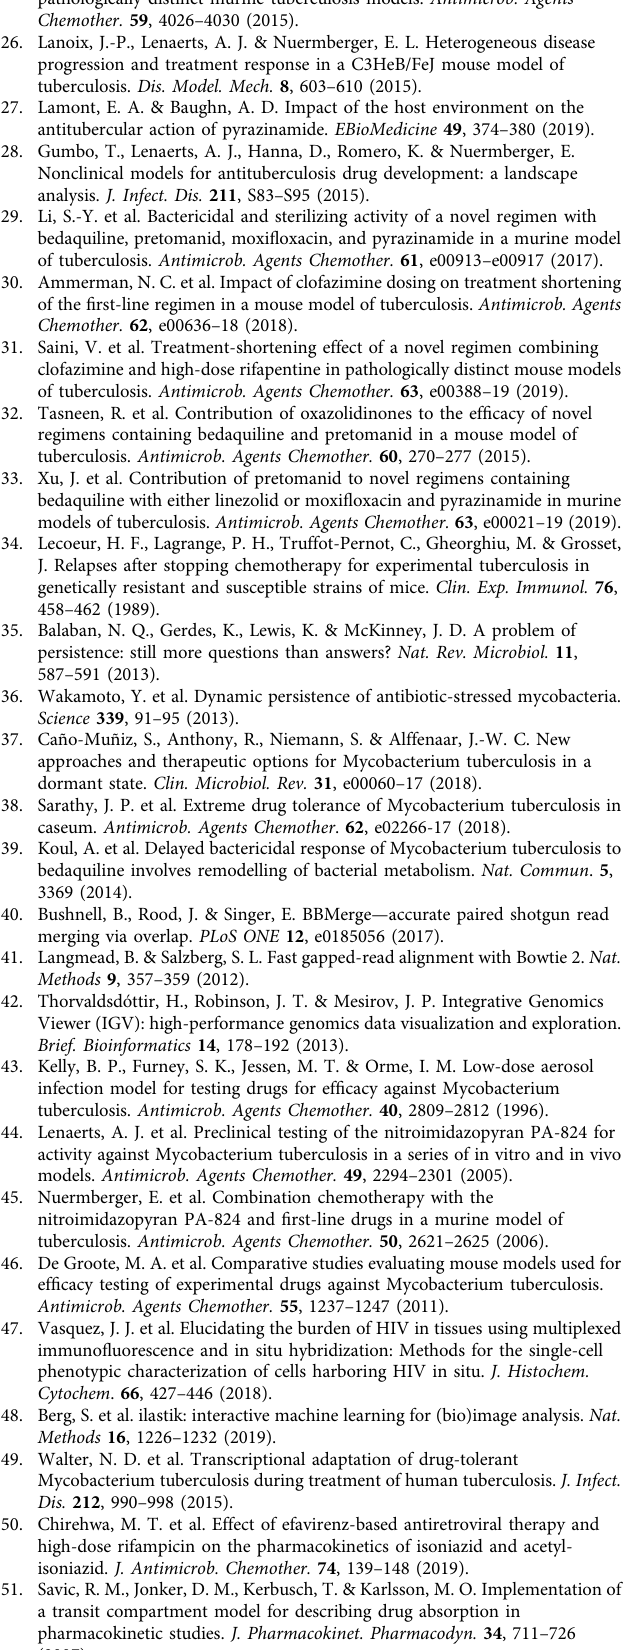
Other source data are provided with this paper in the Source Data fi